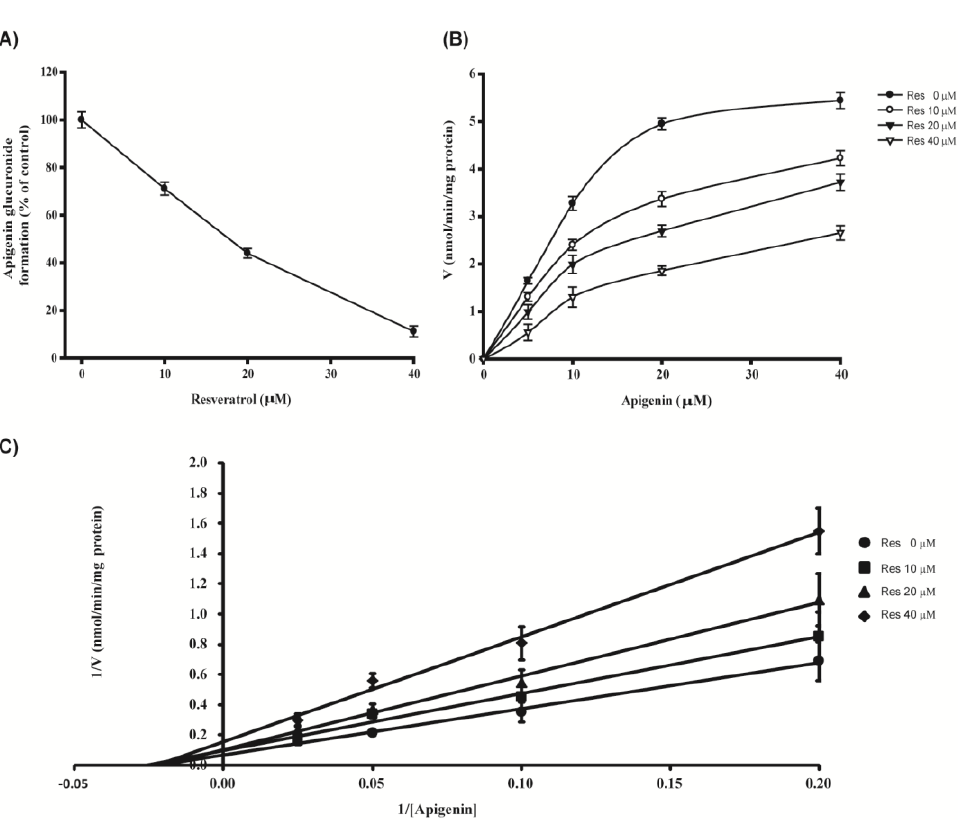
Figure 5. Inhibition of resveratrol towards UGT1A9-catalyzed apigenin glucuronidation ( A ) and kinetic profiles for formation of apigenin glucuronide in the presence of resveratrol by recombinant UGT1A9 ( B and C ). Recombinant UGT1A9 (5 μg of protein) was incubated with 5 to 40 μM apigenin and 2 mM UDPGA at 37 °C for 30 to 360 min in the presence (10, 20, and 40 μM) or absence of resveratrol. Data were represented as means ± SEM and were representative of triplicate experiments. Table 2. Kinetic profiles of resveratrol on glucuronide formation from apigenin by recombinant UGT1A9. V max , K m , and K i values were expressed as best-fit values ± SEM of the estimate and were representative of triplicate experiments.